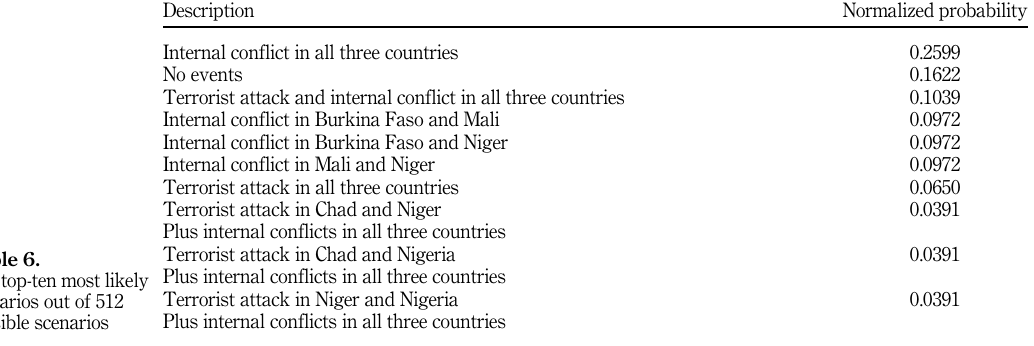
scenarios out of 512 possible